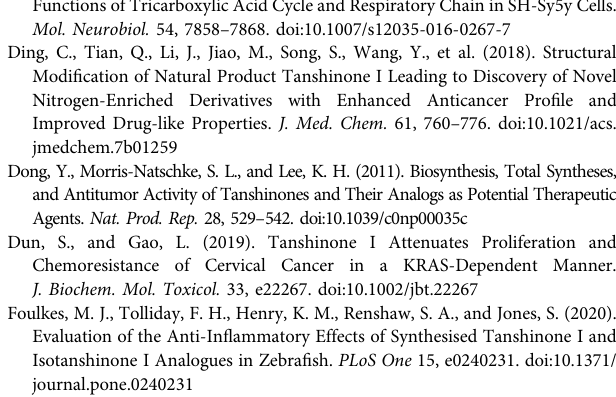
Figure creation — HD. Revision — Q-KS and Z-SQ.